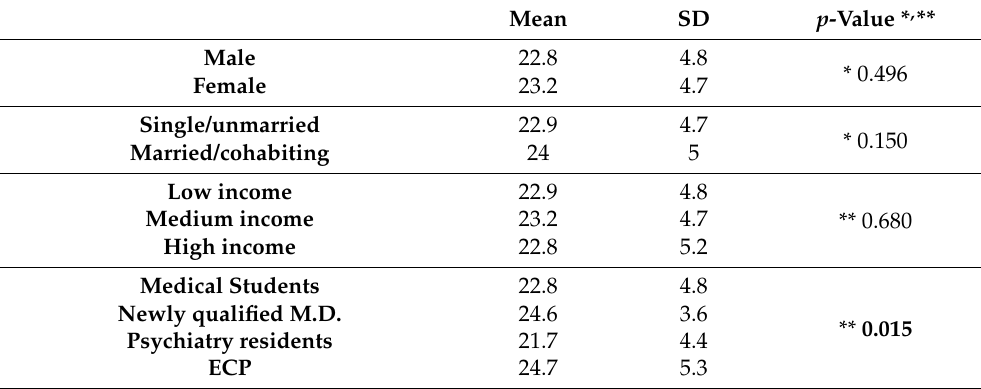
Table 2. Perceived Significance Index according to socio-demographic and training